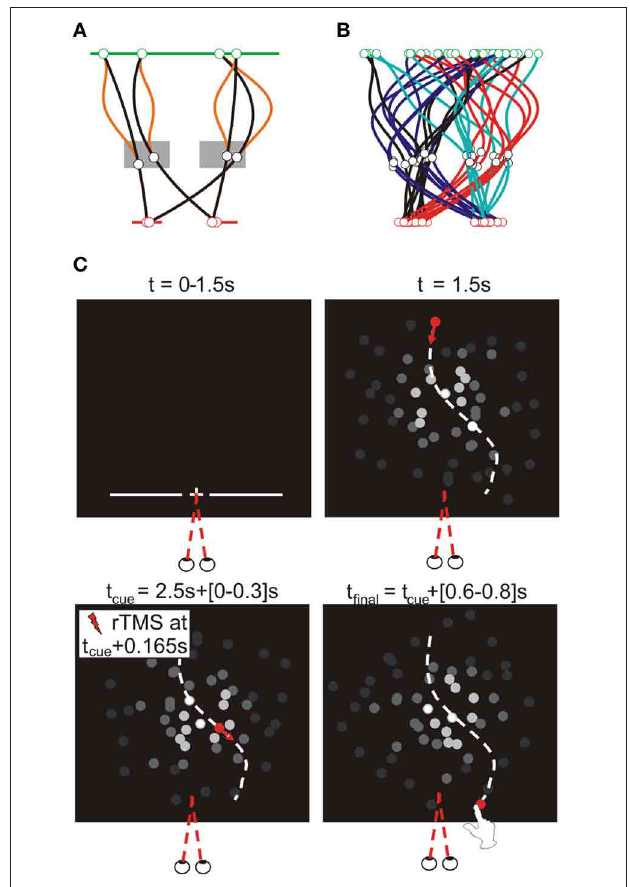
FIGURE 2 | Target trajectories. Target trajectories were generated using the procedure illustrated in (A) . The target appeared 100 pixels below the upper screen edge at a random horizontal position within the central 1000 pixels of the screen (green line). A via point was selected in a zone 80–320 pixels to the left or right of screen center, 538–670 pixels below the upper screen edge (gray rectangles). The final target position was 900 pixels below the upper screen edge and randomly selected within 120–280 pixels to the left or right of screen center (red lines). Target moved downward at a constant velocity (total movement time randomly selected from 1.6 to 2.1s), while its lateral motion was determined by fitting a polynomial through these three horizontal positions as a function of time; to increase unpredictability of the horizontal target motion an additional deviation was added between the first two points [orange lines; α (50–50 cos (2 π t / T1 )), with α randomly selected between − 1 and 1, T1 being the movement time to the via-point]. Given the allowed ranges of target motion times and of the possible via-point positions, the via-point was reached after 1.0–1.3s, after which the final position reached after another 0.6–0.8s. (B) illustrates the typical variability of target trajectories in a block, showing 8 trajectories per trajectory type (as defined by the visual hemifields of the via-point and final point), in different colors. (C) Trial sequence for the interception experiment. As soon as participants pressed the initial position button for 250ms, trials started with the presentation of a fixation point (central, 900 pixels below the upper edge of the screen) for 1.5s. Simultaneously, a line of quasirandom length (600–1000 pixels) appeared centrally at the same height for 1s, reminding participants of the required height of interception. Upon disappearance of the fixation point the moving target appeared. A beep sounded when the target reached the via-point (i.e., 1–1.3s later), informing participants they could initiate their reach to intercept the target at the predefined height (where the target disappeared). In TMS trials, the TMS pulses started 165ms (14 frames) after the initiation